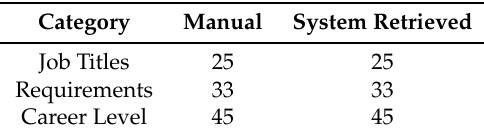
Figure 9. Evaluation comparison of Accuracy vs. Error for SAJ. Table 12. Job description user retrieval summary.